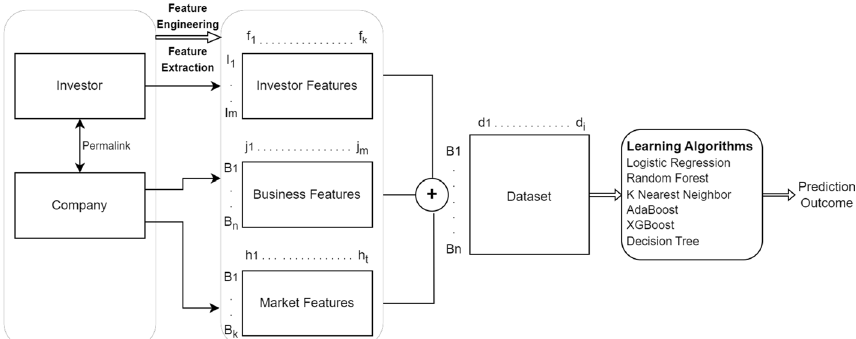
Fig. 9 The proposed system flow chart for business success prediction. The original dataset has two tables: Company and Investor, linked by “permalink”. We first create investor features using Investor table. Business features and market features are derived from the Company table. The three features are consolidated to form IBM features to represent each business for learning and